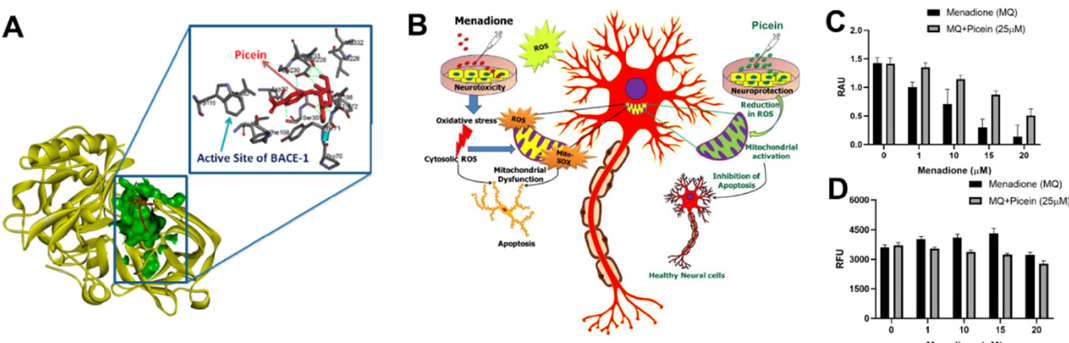
Figure 3. ( A ) In silico identification of putative biomolecular targets for the willow compound picein. BACE1 was found as the most probable target of picein. The docked pose of picein (red sticks) at the active site (green surface presentation) of BACE1 (yellow cartoon). Inset, the active site residues are shown as grey sticks. ( B ) An overview of the neuroprotective effects of picein: ( C ) increase in the level of cell viability, and ( D ) decrease in the level of ROS [72].